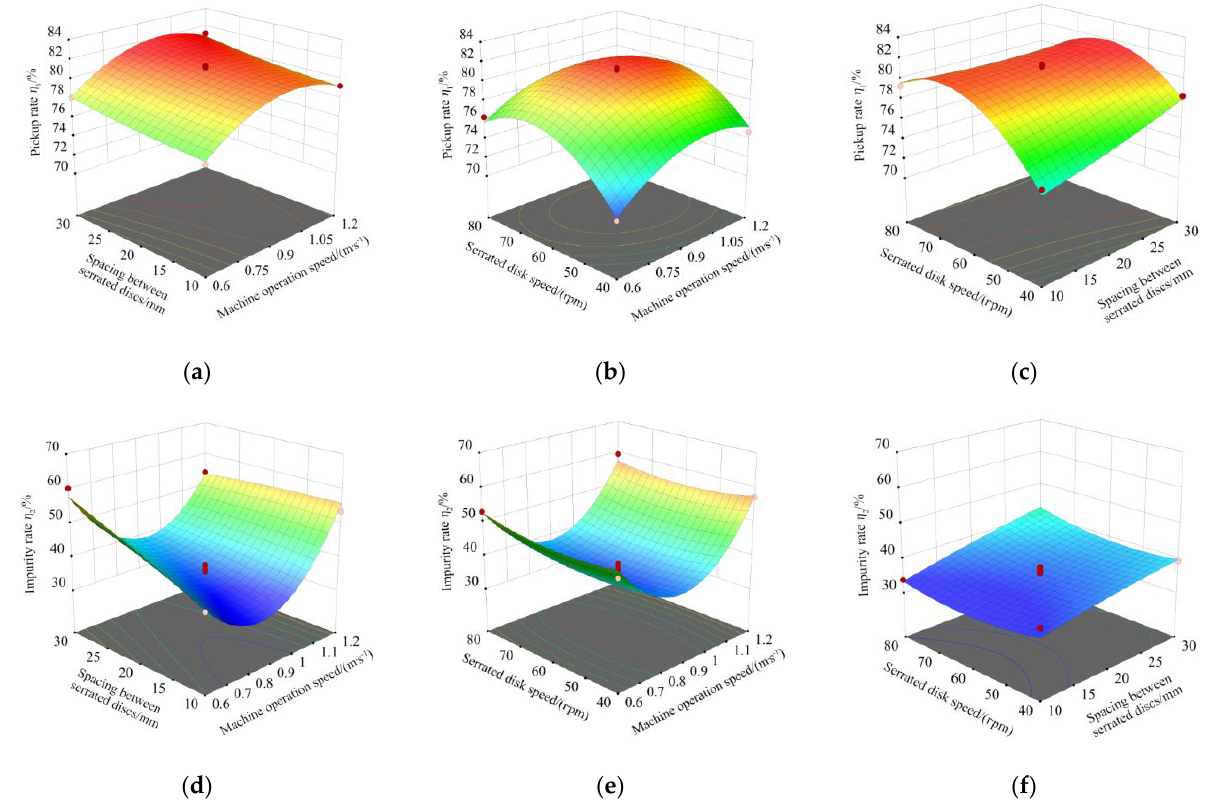
Figure 12. Effects of the interaction of various factors on the picking rate and trash content of cotton fallen on the ground. ( a ). η 1 = ( X 1 , X 2 , 60); ( b ). η 1 = ( X 1 , 50, X 3 ); ( c ). η 1 = (0.9, X 2 , X 3 ); ( d ). η 2 = ( X 1 , X 2 , 60); ( e ). η 2 = ( X 1 , 50, X 3 ); ( f ). η 2 = (0.9, X 2 , X 3 ).